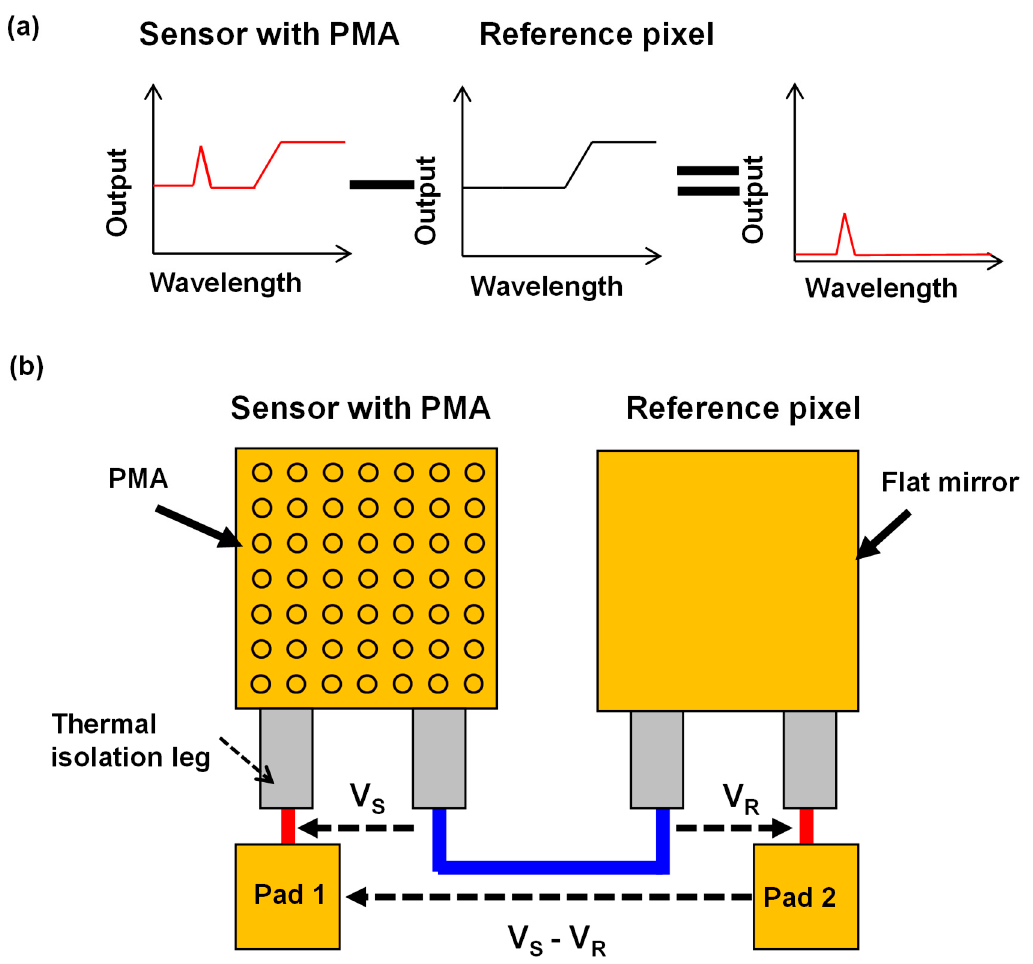
Figure 3. ( a ) Demonstration of the concept to eliminate the unwanted modes using a subtraction operation with a reference pixel. ( b ) Configuration for the subtraction operation between a thermopile with PMA and a reference pixel with flat mirror.